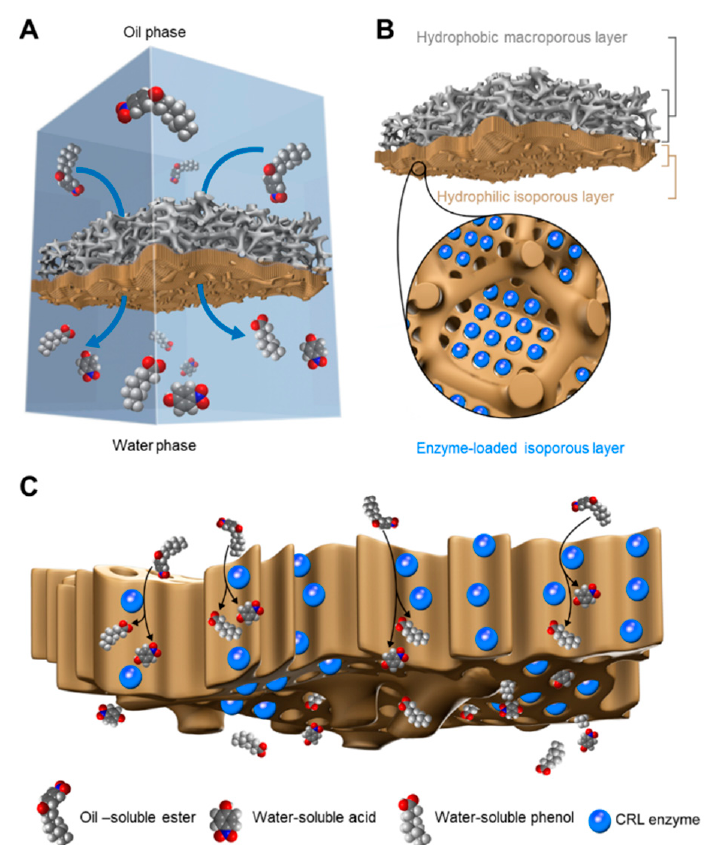
Figure 1. Design scheme of the interfacial catalysis of lipase loaded in a Janus membrane. ( A ) Schematic process of a interfacial catalysis; ( B ) Illustration of the hierarchical multiscale hyperporous structure of lipase loaded Janus membrane; ( C ) Schematic catalysis process inside the hyperporous